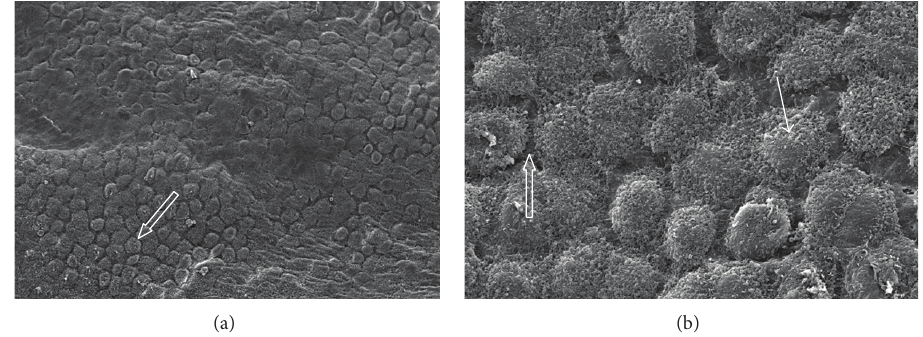
Figure 3: SEM showing mesothelial surface from rats 12h after insufflation with room-temperature, dry CO 2 for 2h at 5 mm/Hg (group 2). Cells are distinctly rounded with some areas of cell flattening and separation (open arrow). Microvilli are collapsed and indistinct (arrow). Some invagination of the tissue suggestive of dehydration is evident in some regions: (a) original × 650; (b) original × 3500.